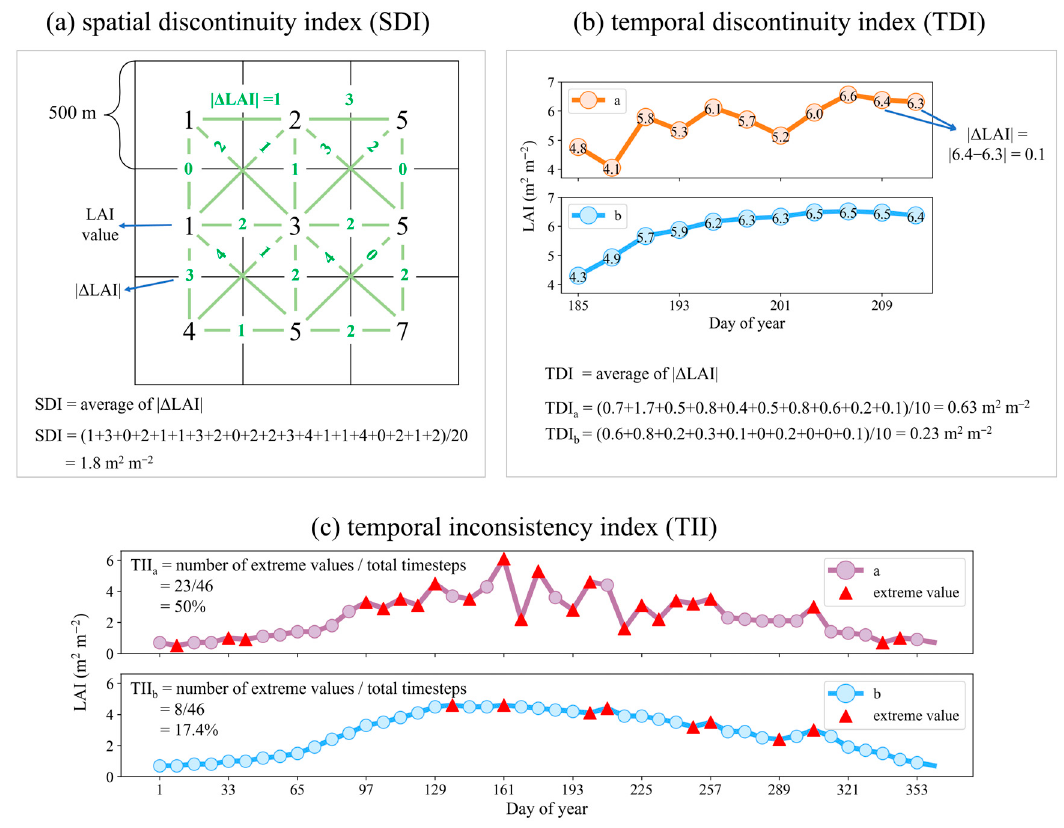
Figure 1. Schematic diagrams for calculating ( a ) spatial discontinuity index (SDI), ( b ) temporal discontinuity index (TDI), and ( c ) temporal inconsistency index (TII). | ∆ LAI | represents the absolute difference between the adjacent LAI values. TDIs and TIIs of different time series were calculated as an example to exhibit different extents of ( b ) temporal discontinuity, and ( c ) temporal